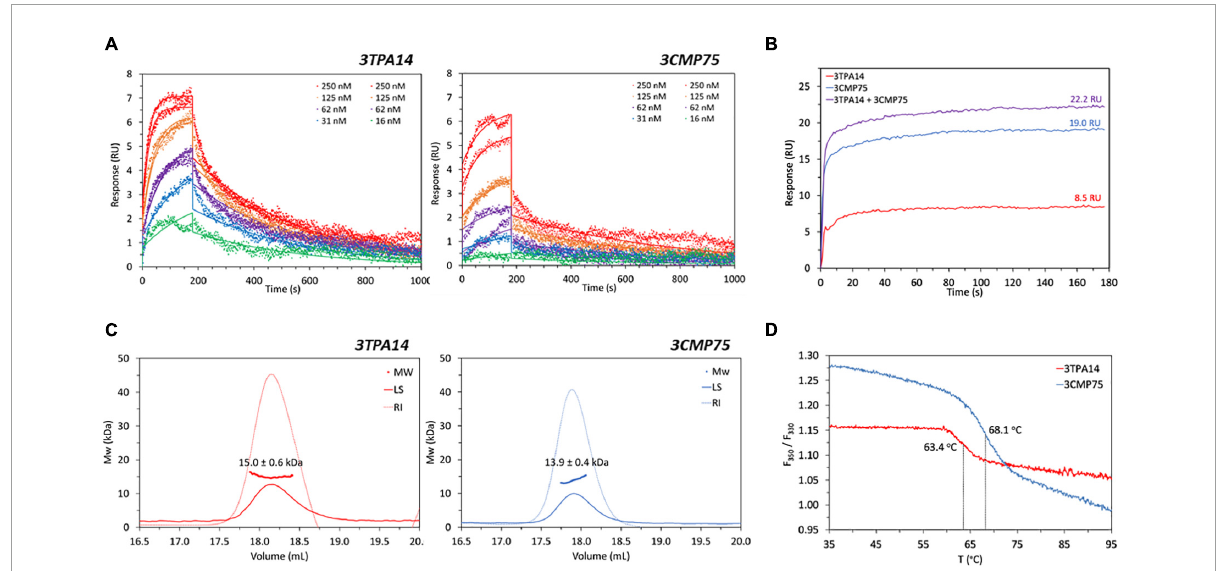
FIGURE4 Biophysical characterization of the selected 3TPA14 and 3CMP75 nanobodies. (A) Surface plasmon resonance (SPR) titrations. Overlay of SPR sensorgrams and corresponding kinetic fits to a 1:1 binding model (solid line) of 3TPA14 and 3CMP75 nanobodies with MT1-MMP immobilized on a sensor chip. Replicate injections were done at 250, 125 and 62 nM nanobody concentrations. (B) SPR 3TPA14/3CMP75 competition. Overlay of SPR association sensorgrams showing absence of competition for the same MT1-MMP epitope between 3TPA14 and 3CMP75. Shown are the responses during three consecutive 3 min injections to immobilized MT1-MMP of 1.6 µ M 3TPA14, 3.6 µ M 3CMP75 and 1.6 µ M 3TPA14 + 3.6 µ M 3CMP75 mixture. (C) Size-exclusion chromatography combined with multiangle light scattering (SEC-MALS) Analysis. Chromatographic traces of light scattering at 90 ◦ (LS; solid lines), refractive index (RI; dashed lines) and the calculated molecular weight of the peaks from 3TPA14 and 3CMP75. (D) NanoDSF (Differential Scanning Fluorimetry) thermal unfolding profiles of nanobodies 3TPA14 (red line) and 3CMP75 (blue line). Following the change in fluorescence intensity ratio at 350 and 330 nM (F350/F330) with temperature, inflection temperatures of 63.4 and 68.1 ◦ C were determined for 3TPA14 and 3CMP75, respectively.